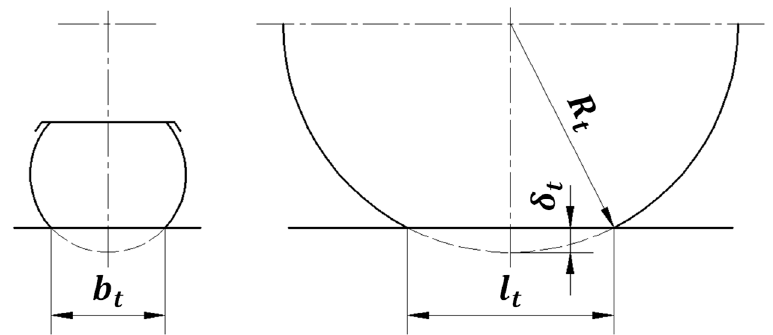
Figure 4. Diagram of contact between the tire and pavement.